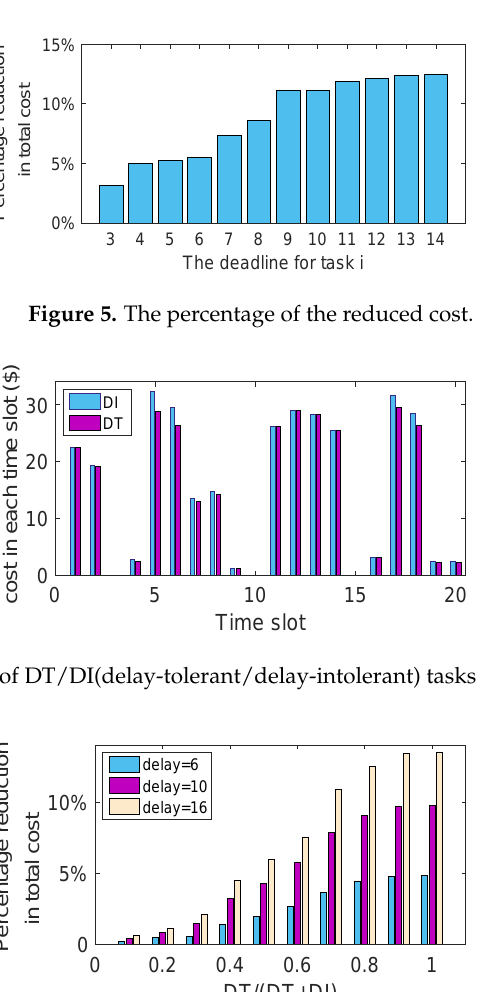
Figure 4. Battery level in time slot t .